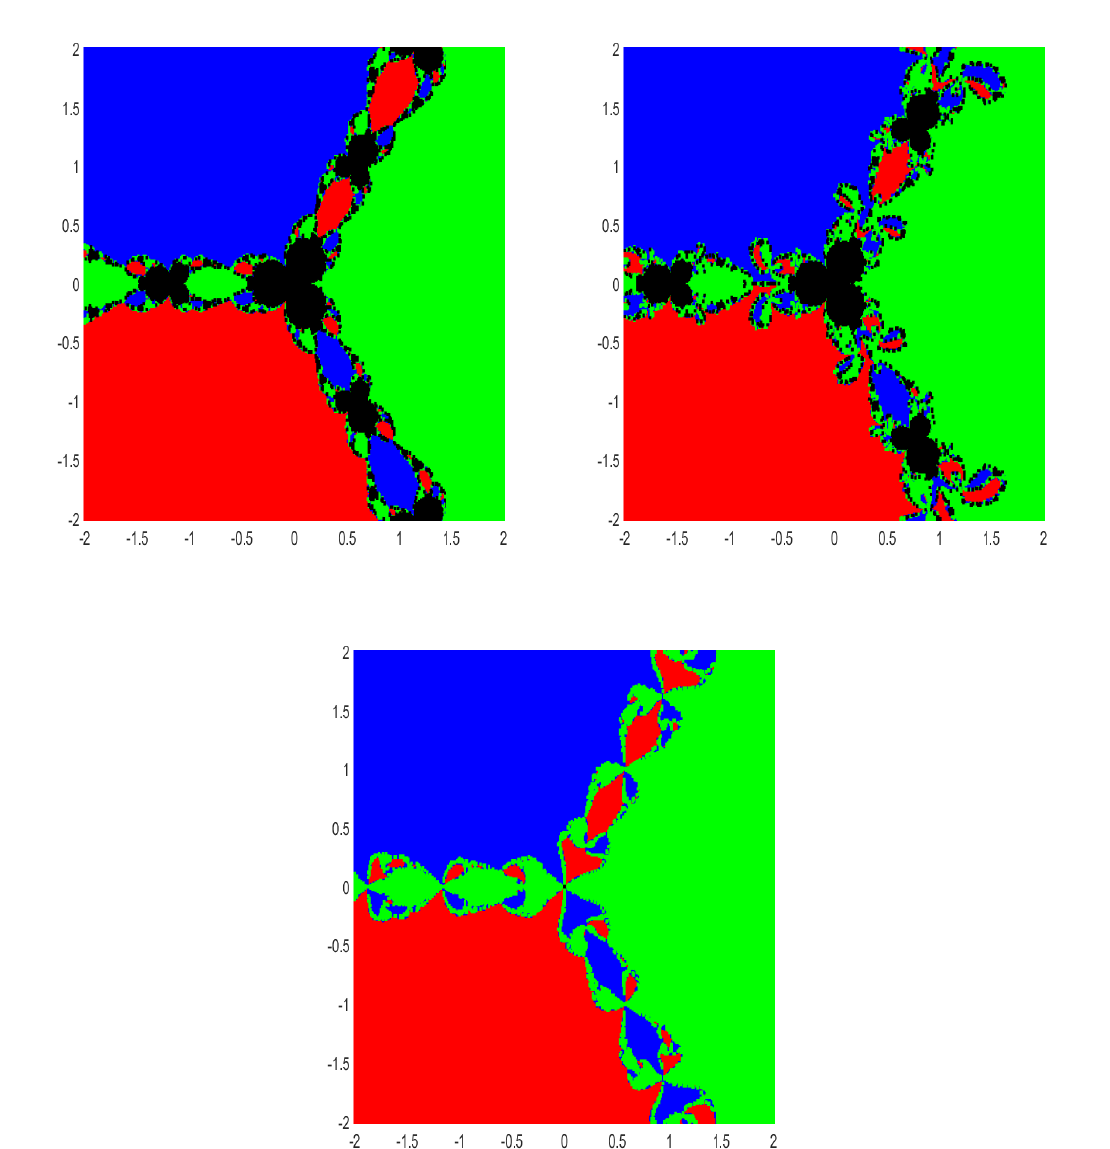
Figure 2. Dynamics of (2), (3) and (4), respectively, with BA, for Example